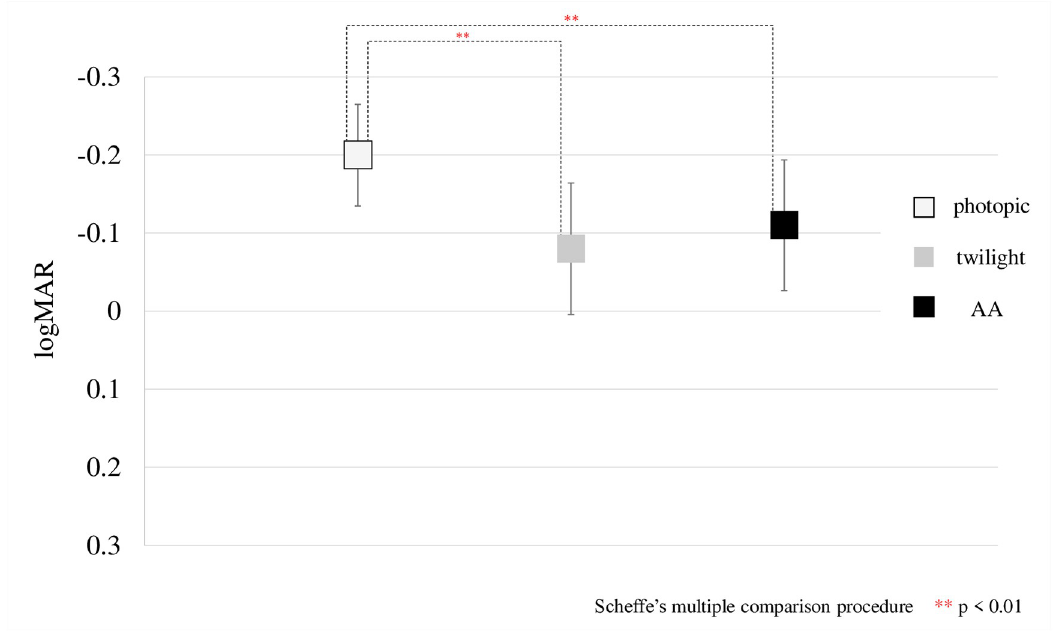
Fig 2. Results of logMAR visual acuity in photopic and twilight and AA are shown. When the results of these three conditions are analyzed using the Friedman test, p < 0.001 is obtained. Therefore, Scheffe’s multiple comparison procedures are performed, and the difference is significant at p < 0.001 between photopic and twilight, and p < 0.001 between photopic and